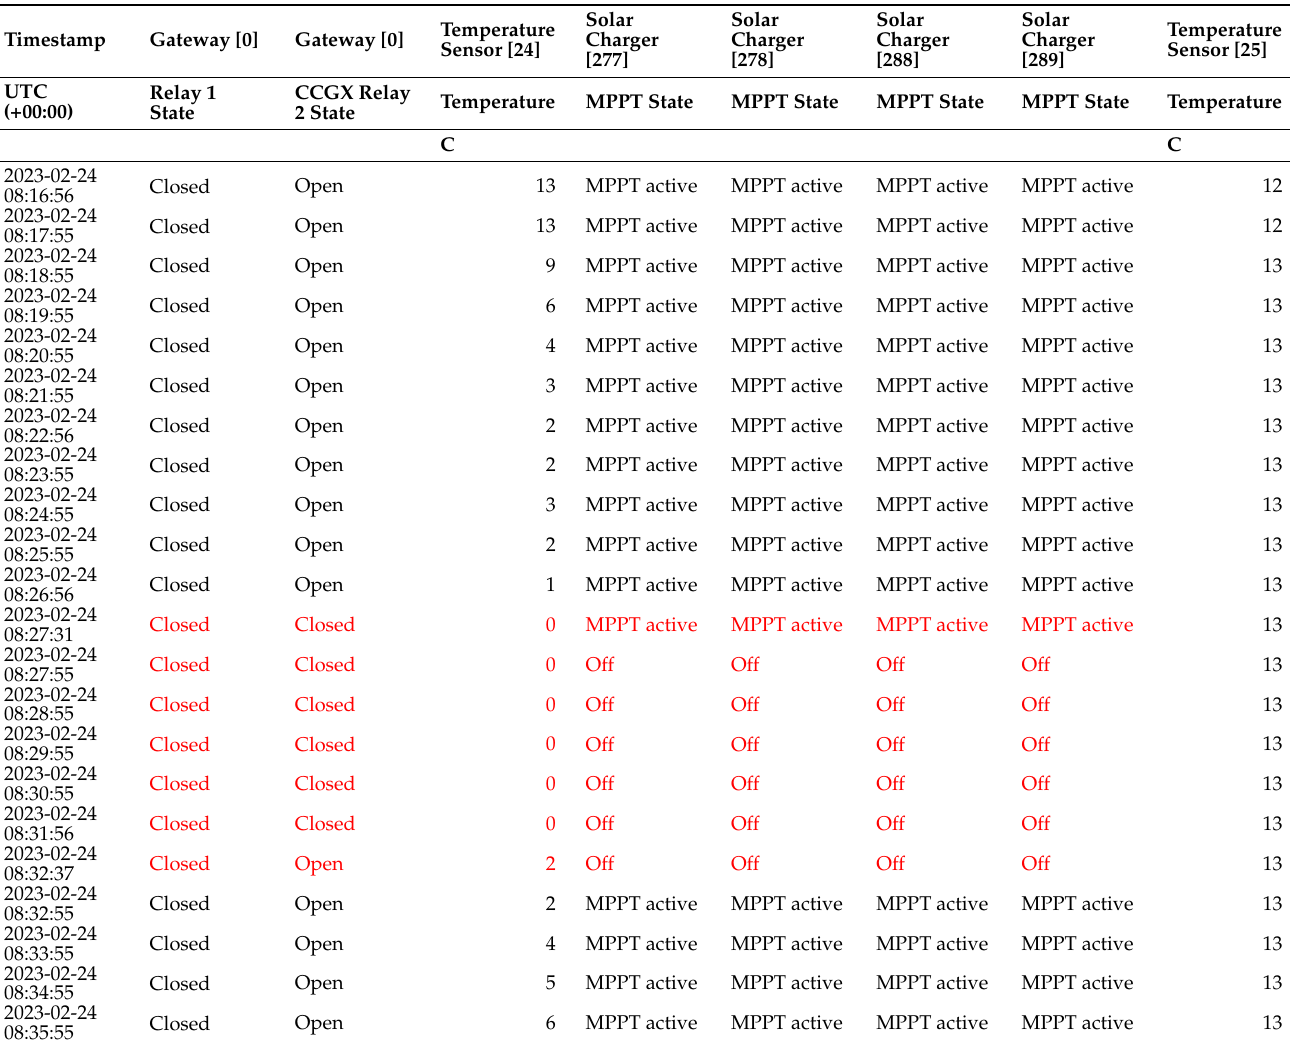
Table 7. Capture in test based on low-temperature alarms in the battery using Temperature Sensor 24, acting on Relay